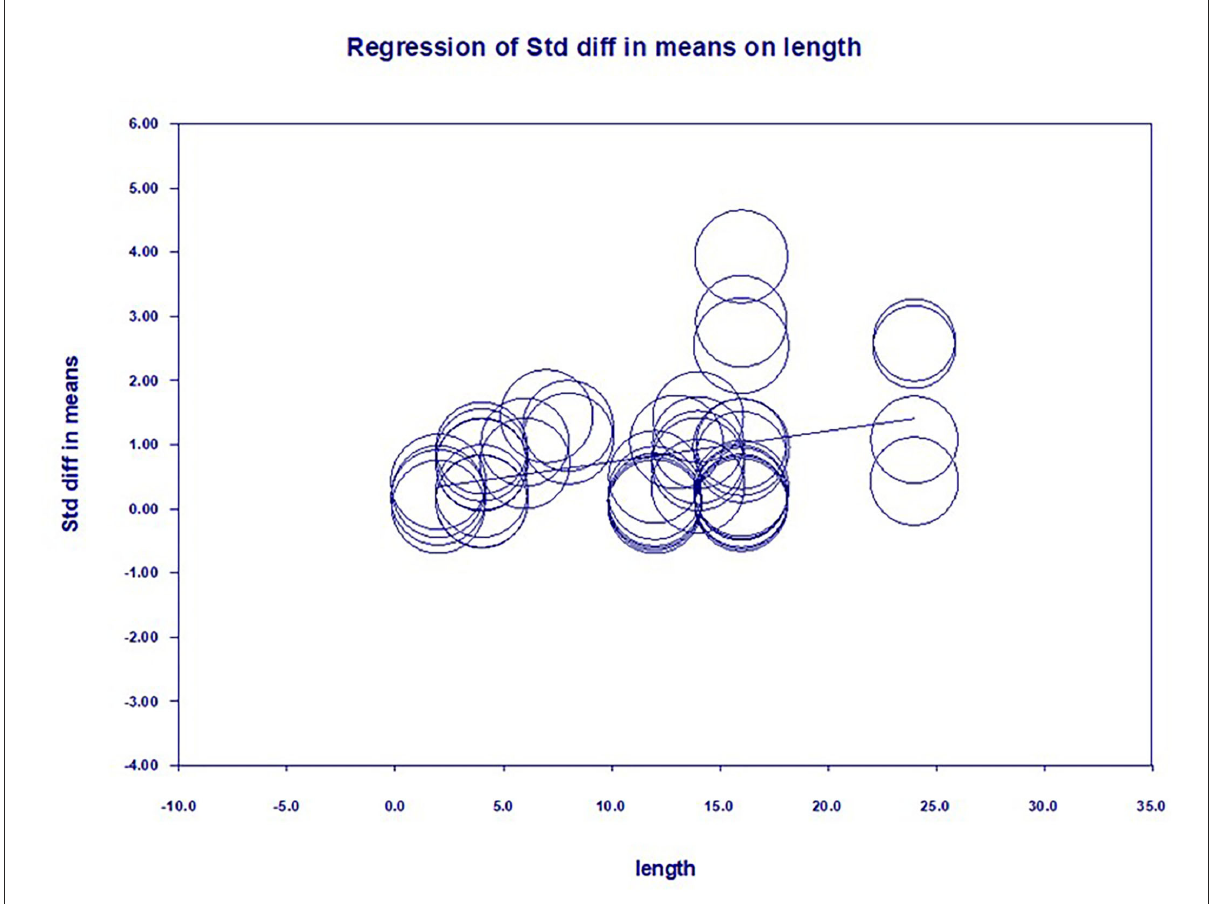
FIGURE4 Regression curve of intervention length and intervention